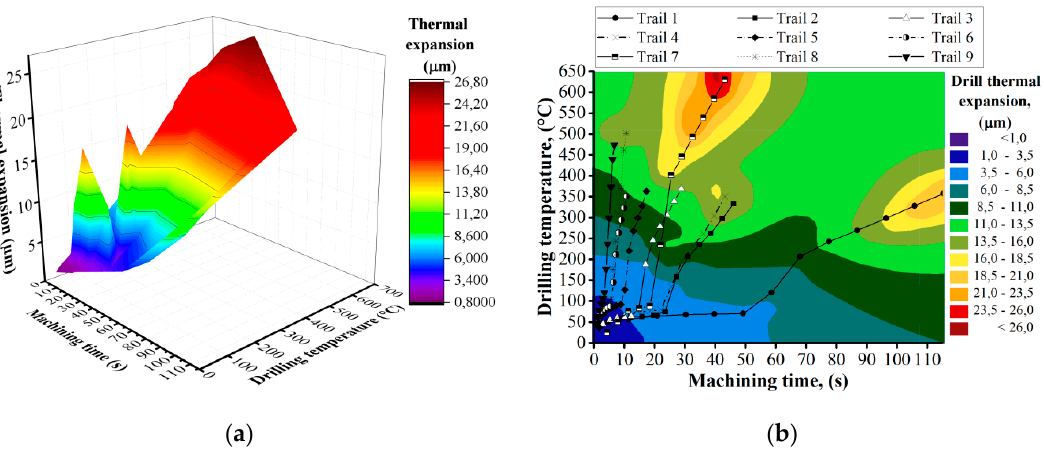
Figure 1. Schematic illustration of the FE model of a drill.